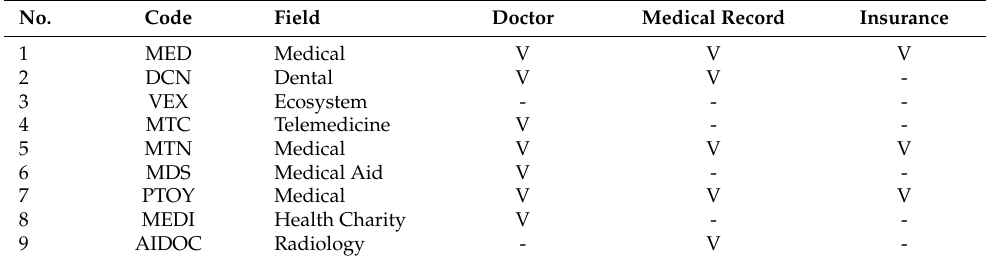
Table 7. Medical project